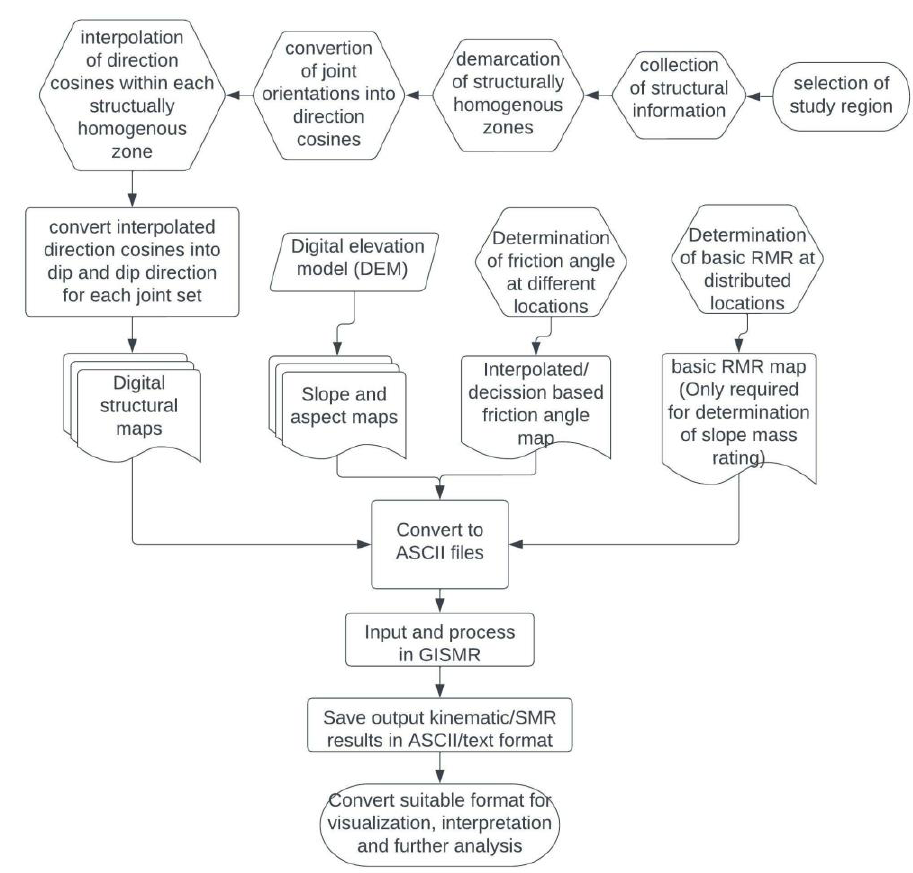
Figure 5. Workflow for determination of structural stability in a large region using GISMR.